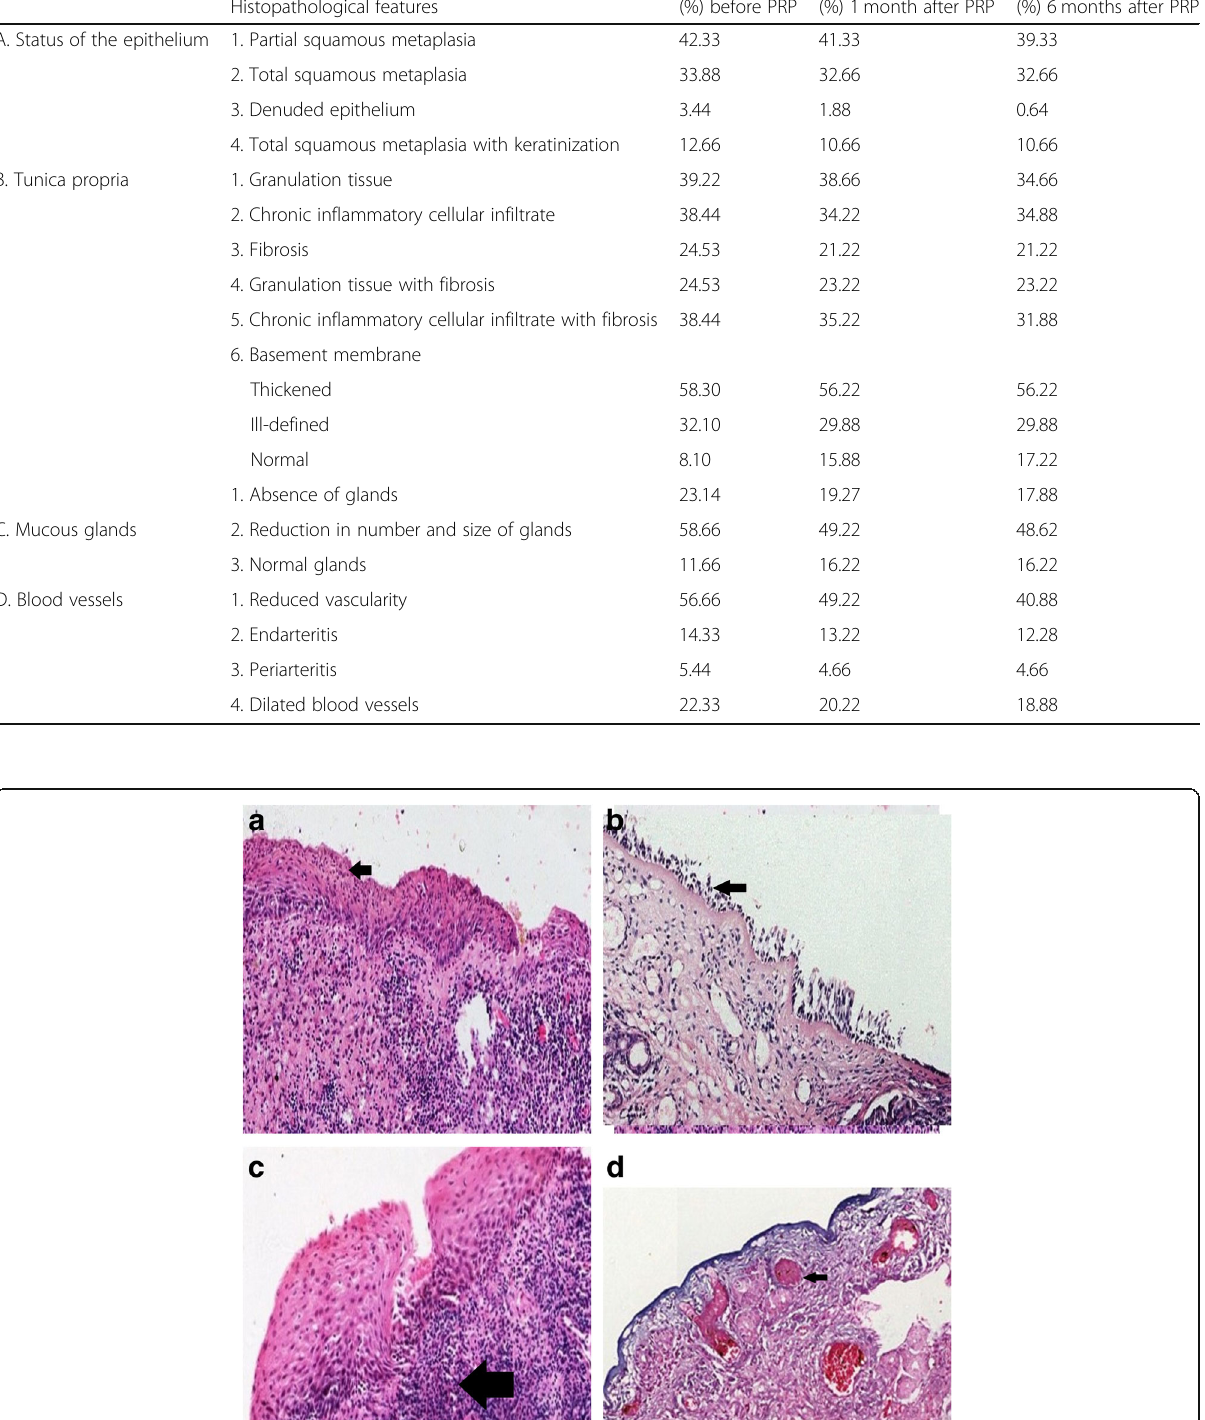
Table 2 Histopathological features in group A, before, 1 month and 6 months after PRP treatment Histopathological features